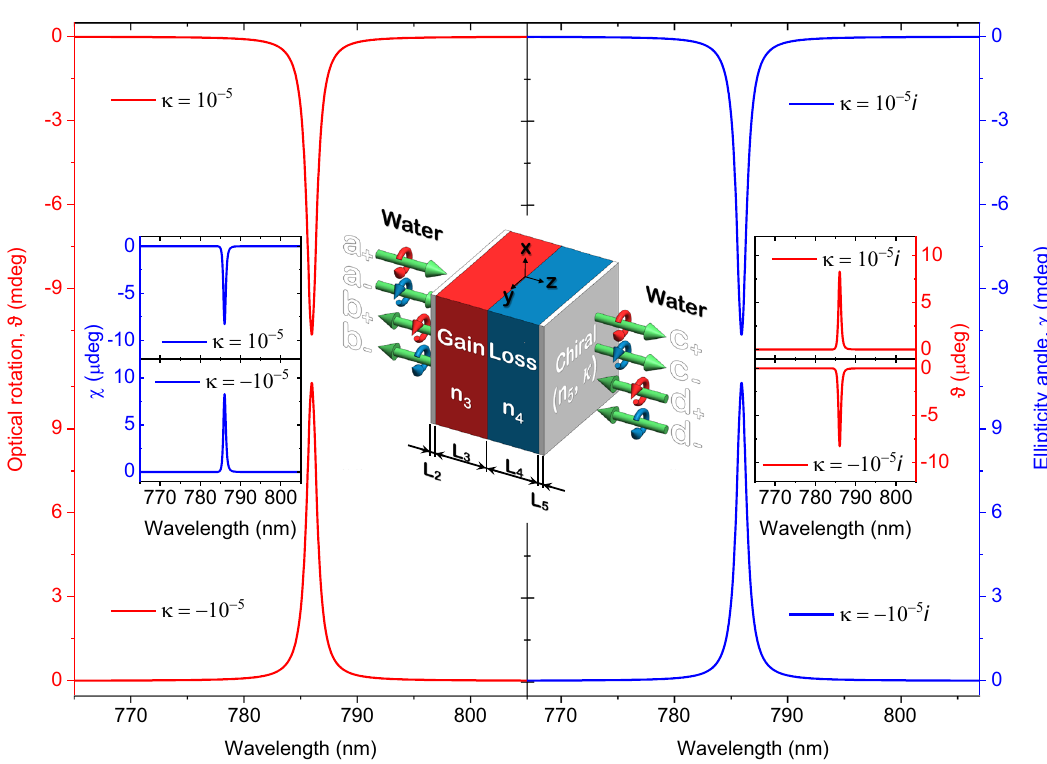
Fig. 2 Spectra of chirality-dependent optical rotation ϑ and ellipticity angle χ . The exterior surfaces of S PT are decorated with a chiral substance characterized by a chirality parameter κ = κ 2 = κ 5 and an average refractive index n c = n 2 = n 5 to form S C system. a , d and b , c represent the complex electric- fi eld amplitudes of normally incident and scattered CP waves propagating along the z axis, respectively. The + ( − ) sign in the subscript indicates LCP and (RCP) states, respectively. Spectra of optical rotation ϑ and ellipticity angle χ (inset) for the purely real κ = ±10 − 5 (left column). Spectra of χ and ϑ (inset) for the purely imaginary κ = ±10 − 5 i (right column). ϑ and χ are obtained from the CPA-locked S C system with n c = 1.33 + 10 − 4 i and the chiral layer thickness L c = L 2 = L 5 = 1 nm. CPA is an acronym for coherent perfect absorption.